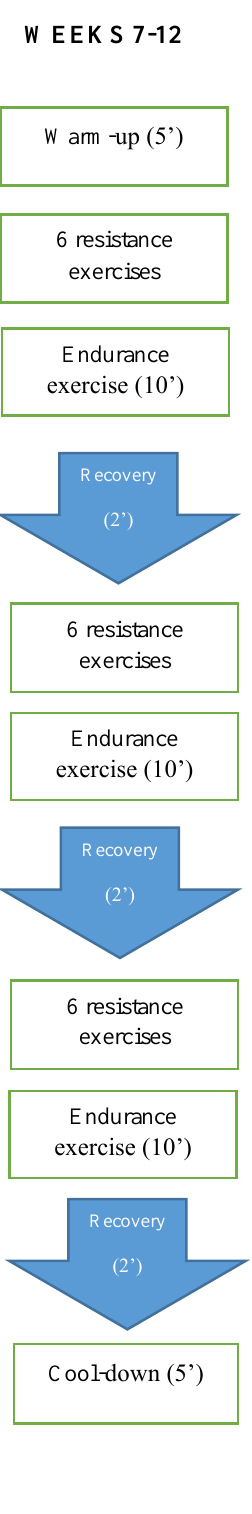
Figure 2. COM training protocol.